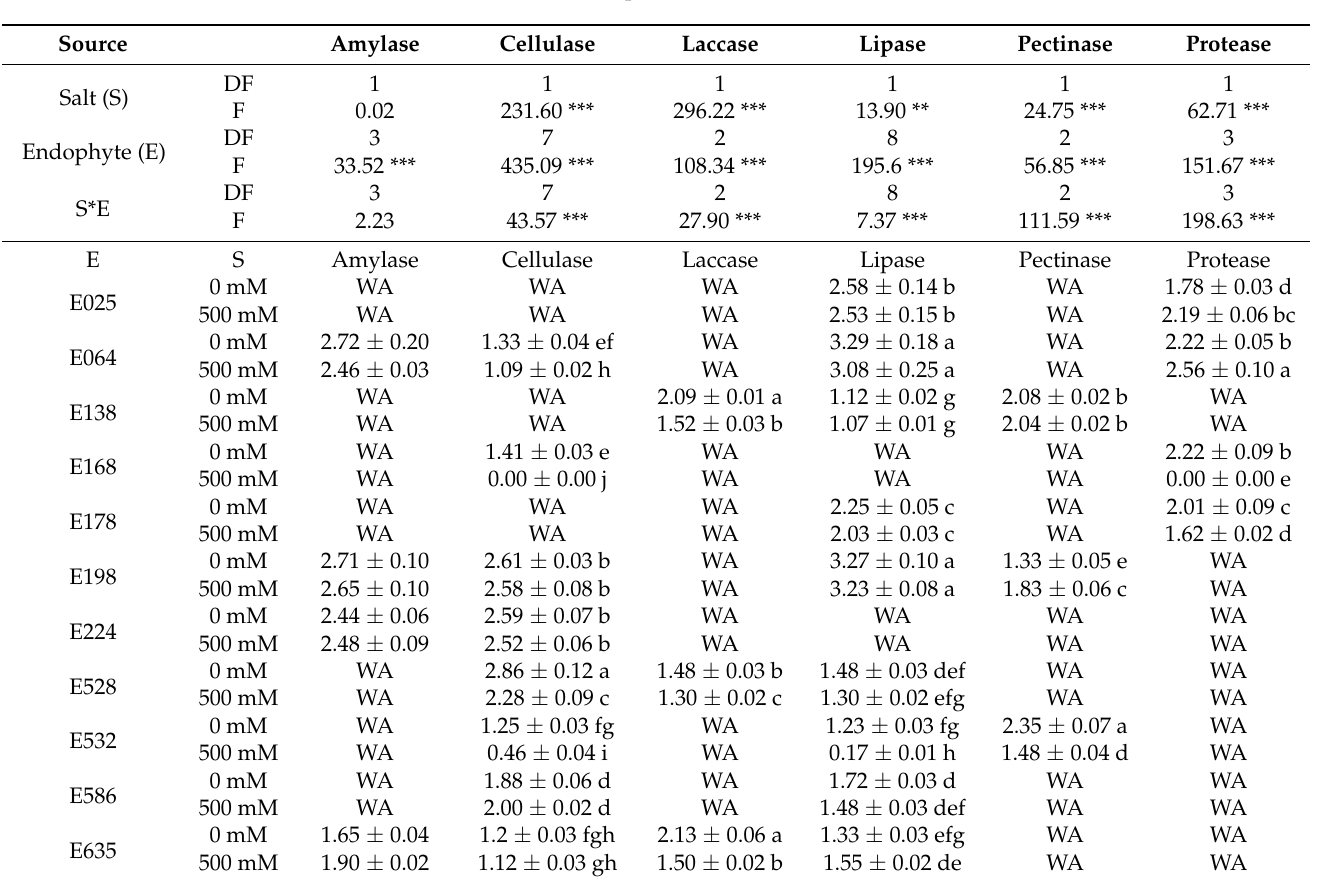
Table 3. Enzymatic production under different salt conditions by the selected strains. The positive results (mean ± se) are shown as the solubilization index ((colony + halo zone diameters)/colony diameter). A summary of the ANOVA (DF: degree of freedom; F values; and level of significance (** p ≤ 0.01, *** p ≤ 0.001)), showing the effect of the endophyte, the salt concentration, and their interaction, is shown for each parameter. Cellulase Laccase Lipase Pectinase